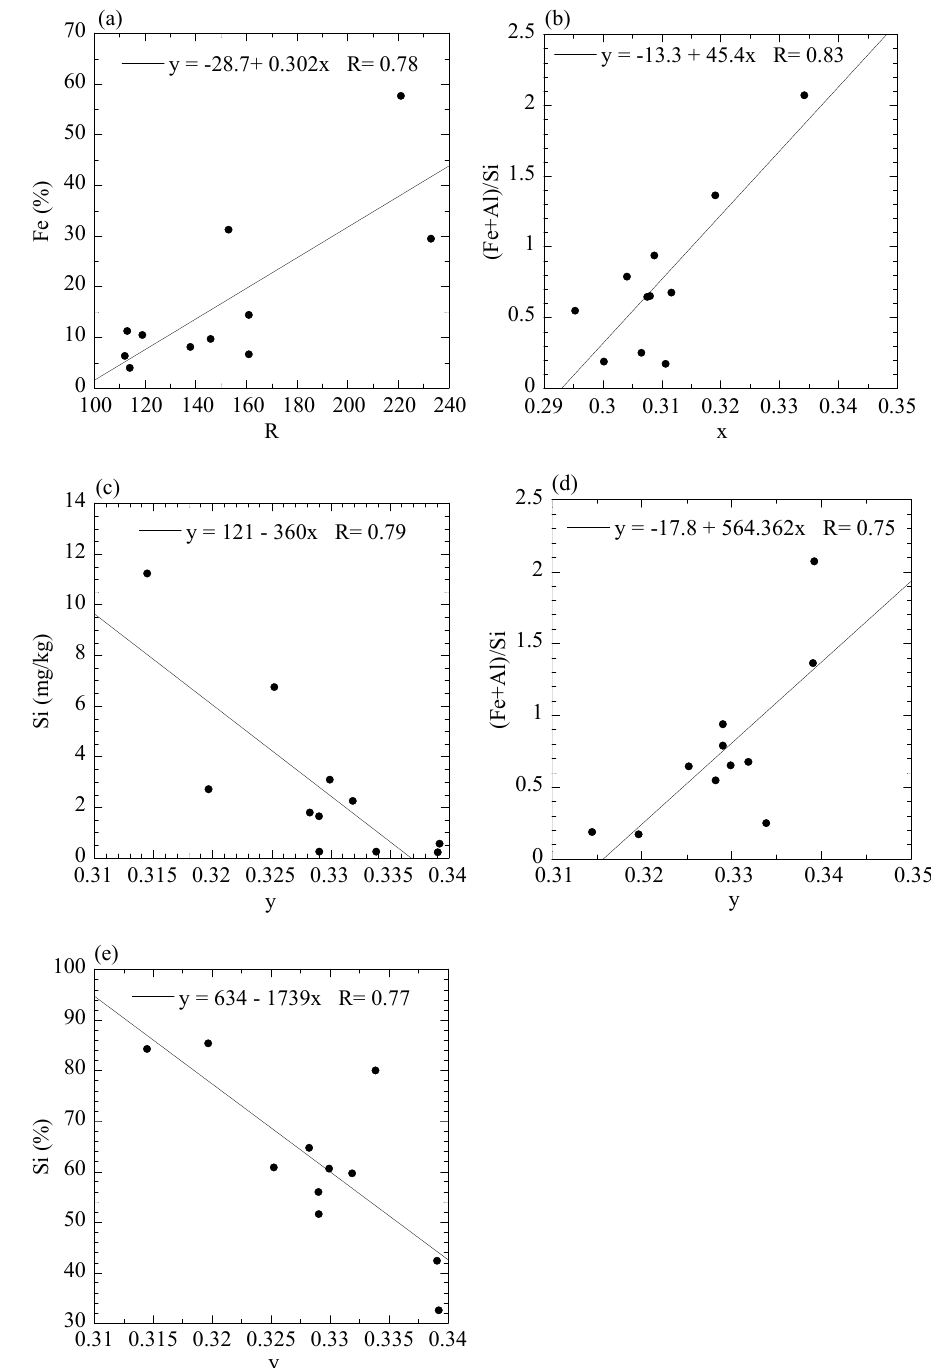
Figure 4. Examples of the relationship between the parameters of discolored seawater color parameters (R, x, and y) and its chemical composition (Fe, (Fe + Al)/Si, and Si). ( a ) R vs Fe%, ( b ) x vs (Fe+al)/Si, ( c ) y vs Si%, ( d ) y vs (Fe+Al)/Si, ( e ) y vs Si%.